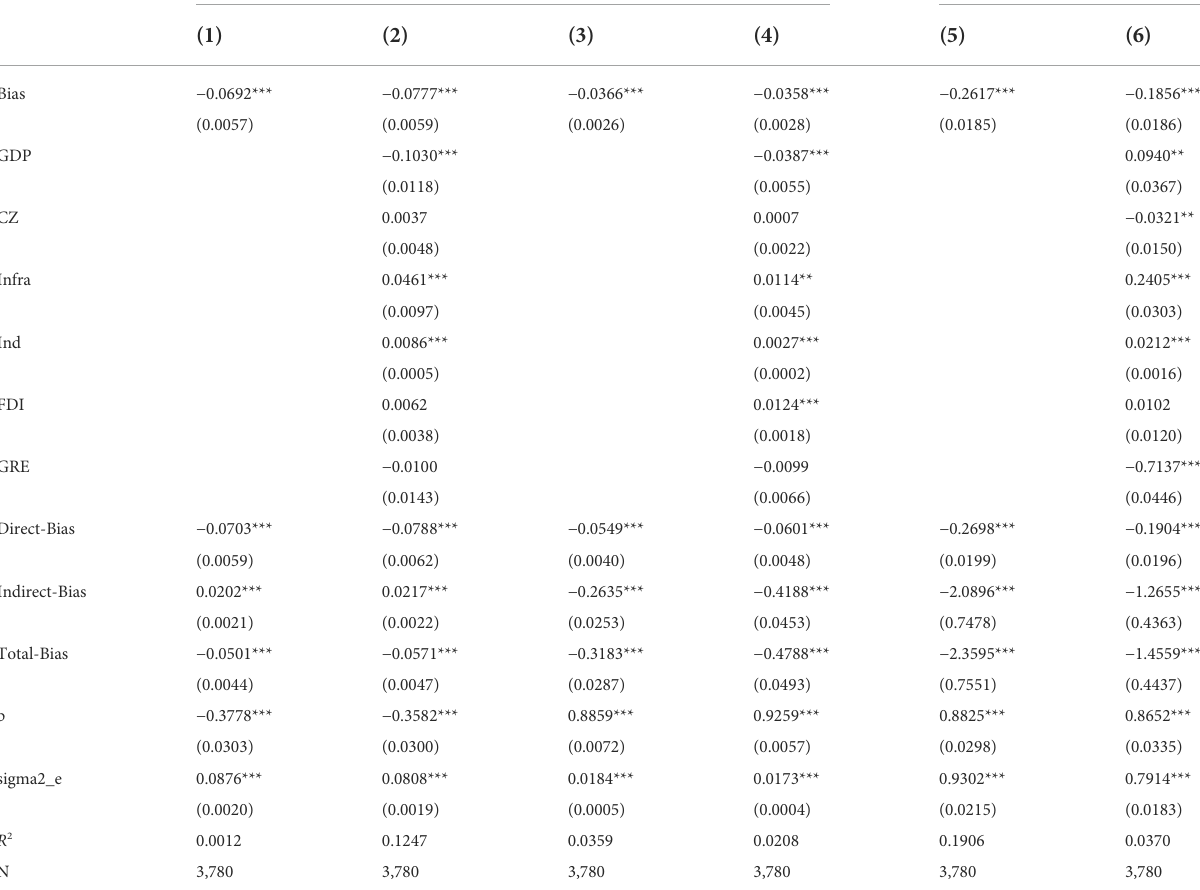
TABLE 6 Robustness test.